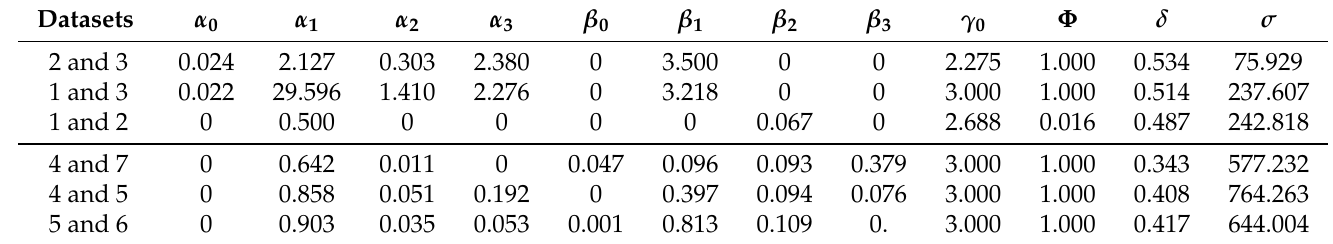
Table 7. Calibrated parameters in Scenario 2 (CBS).